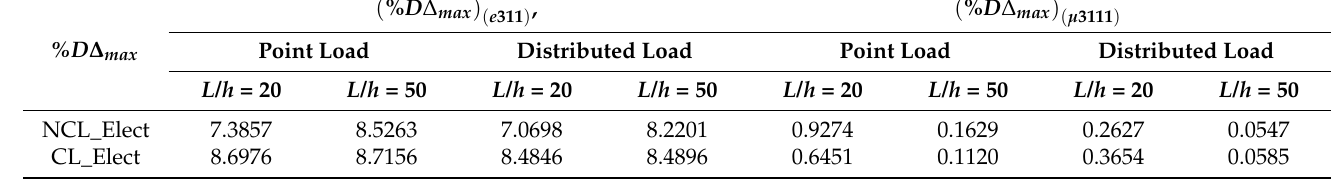
Table 8. The relative percentage difference in the transverse deflection due to increasing the piezo- electric coefficient e 311 and the electric-field–strain-gradient coupling coefficient ( µ 3111 ) for electrome- chanical and mechanical nonclassical and classical behaviors for different values of filling ratio under point and uniformly distributed loads at beam aspect ratio L / h = 20, 50, abs( e 311 ) = − (0 to 15) C/m 2 , abs ( µ 3111 ) = (0 to 10) × 10 − 8 C/m, a 33 = 7.124 × 10 − 9 C/m 2 K, K w = 50, K p = 5, α = 0.5, N = 4, ea = 4 and l = h h